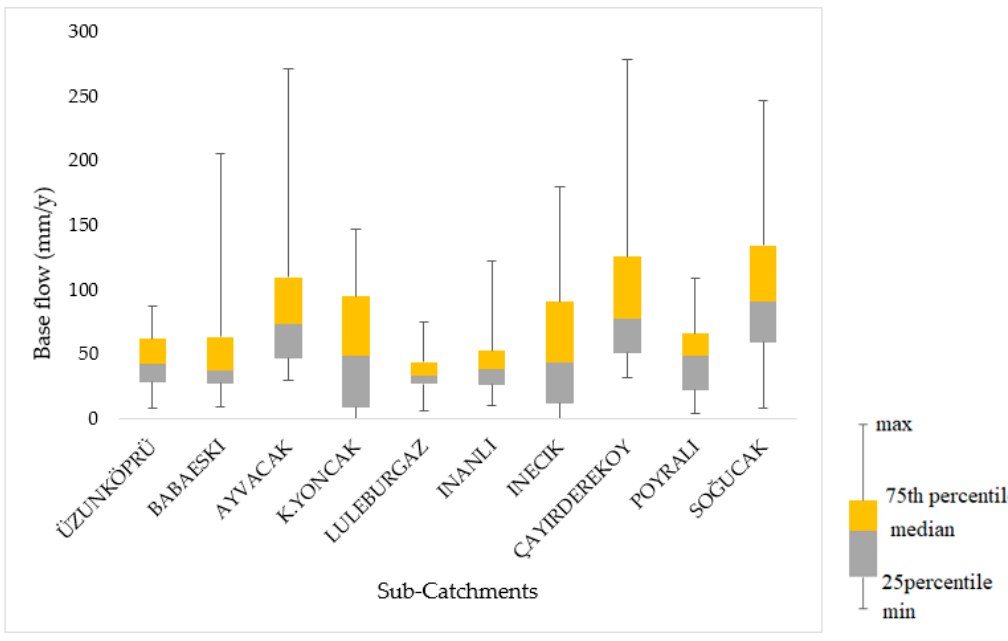
Figure 10. Descriptive statistics of base flow by subcatchments.